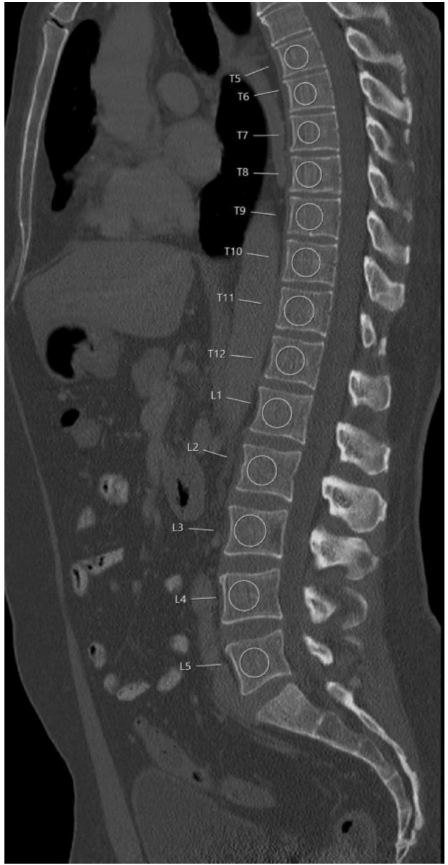
Figure 1. Representative placement of the regions of interest (ROIs). ROIs were placed in the ventral halves of the trabecular compartment of the vertebral bodies, equidistant to both endplates, excluding the venous